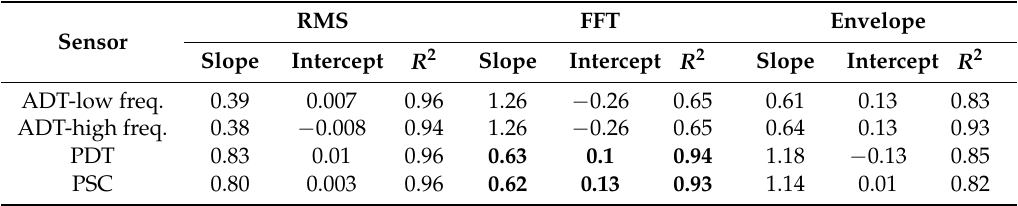
Table 2. Summary of the correlation between relative indicators values and relative RMS of the oscillating power